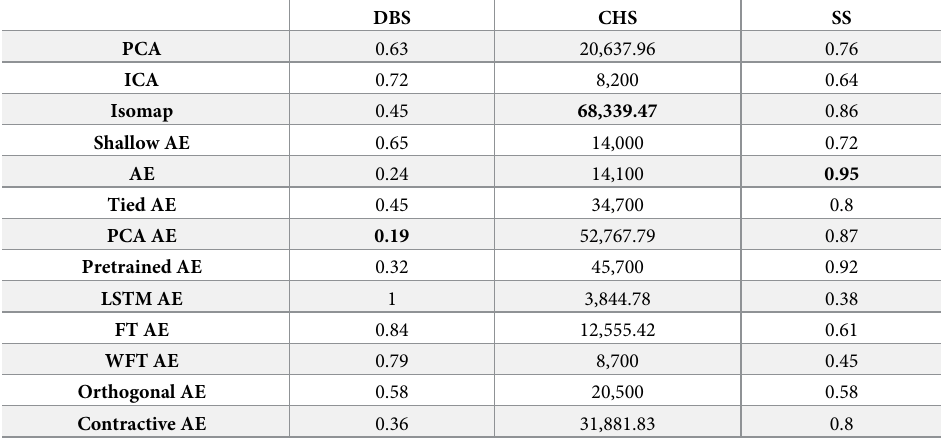
Table 9. Comparison of different autoencoder variations vs state-of-the-art methods on real data channel 17, the optimal value of neighbours for Isomap was found as 20 through grid search. The metrics indicate that the AE vari- ant is able to outperform the conventional feature extraction algorithm with the exception of the CHS metric, while the performance of the other variants varies across metrics due to the fact that the internal metrics evaluate the quality of the clustering from different perspectives as no ground truth is available for real data. The values indicating the highest performance for each metric have been bolded.